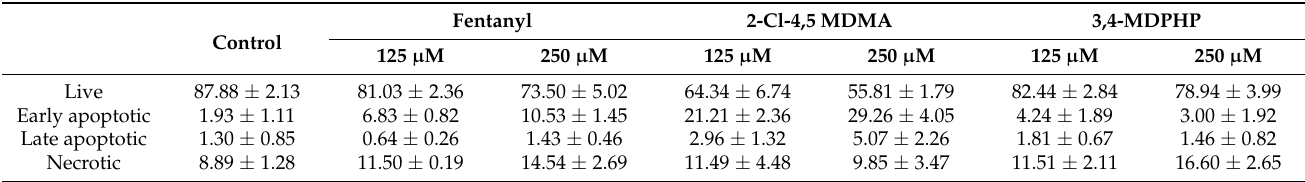
Table 1. Percentage of early and late apoptotic and necrotic SH-SY5Y cells following treatment with 3,4MDPHP, 2-Cl-4,5-MDMA, and fentanyl, measured by flow